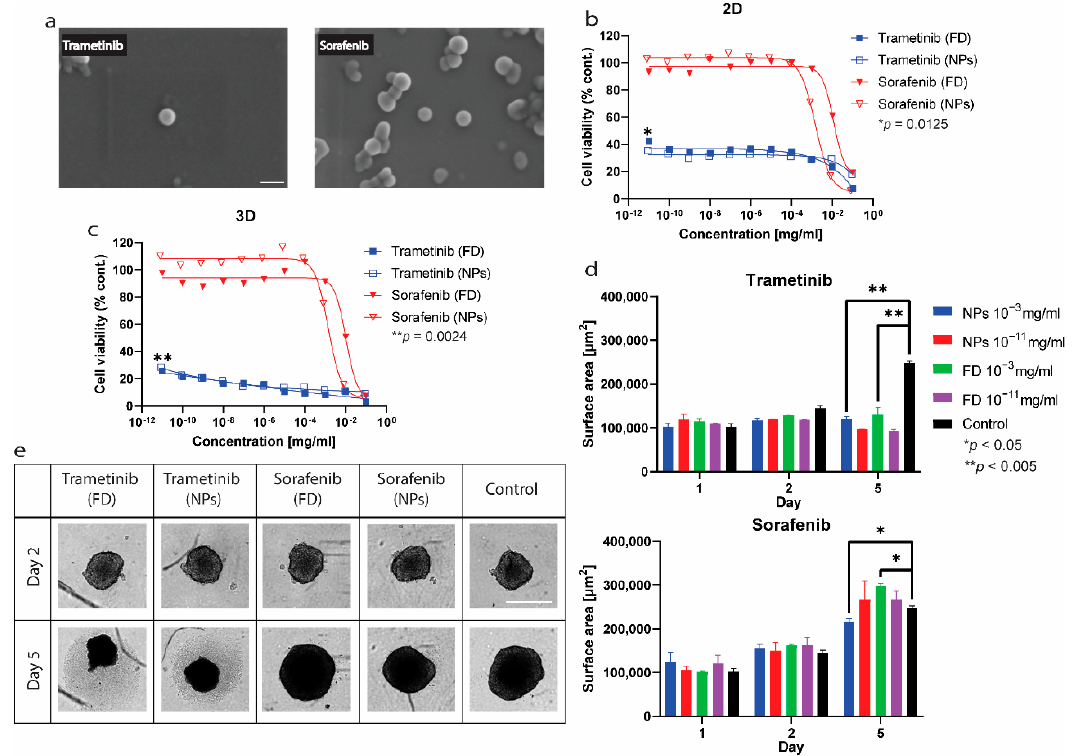
Figure 10. Cell viability assays in 2D and 3D models of HCT116. ( a ) HR-SEM images of the trametinib and sorafenib nanoparticles stabilized by PDA-PDO-In820, scale bar = 100 nm. ( b ) CTG 2D results of HCT 116 cells after 4 days of treatment. abbreviations: FD = free drug, NPs = nanoparticles. ( c ) CTG 3D results of HCT 116 spheroids after 5 days of treatment. ( d ) Change in spheroids size during the treatments. ( e ) Spheroids images on the 1st and 5th days of the treatment. Drugs and NPs concentrations = 10 − 3 mg/mL, scale bar = 500 μ m.